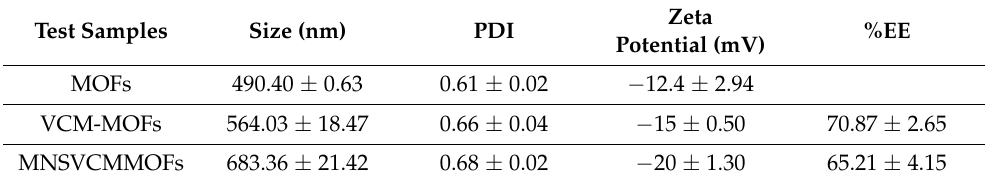
Table 2. Size, zeta-potential, PDI, and drug loading efficiency (DLE) characterization.